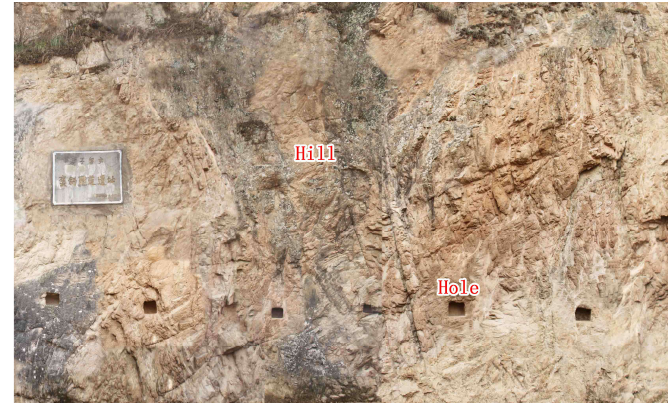
Figure 2. Image of the hole areas on the Chiya Plank Road